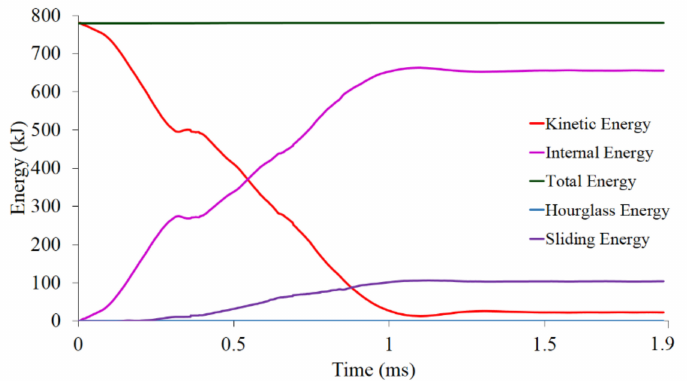
Figure 11. Battery energy validation